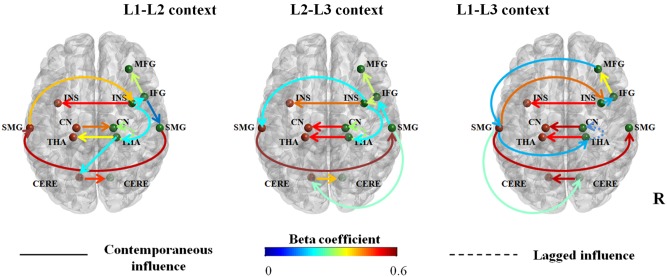
Connectivity maps for inhibitory control process in three dual-language contexts (L1-L2; L2-L3; L1-L3). Significant contemporaneous and lagged relationships at group-level were shown, and auto-regressive lagged connections are omitted for clarity. Connection strength is denoted by beta coefficients, reflected here as the color the line. The solid line indicates contemporaneous relationship, namely area X at time T influences brain activation of area Y at time T; dotted line illustrates lagged relationship, namely area X at time T influences brain activation of area Y at time T + 1. Nodes (ROIs) are MFG, middle frontal gyrus; IFG, inferior frontal gyrus; INS, insula; CN, caudate nucleus; THA, thalamus; SMG, supramarginal gyrus; CERE, cerebellum; R, right hemisphere.